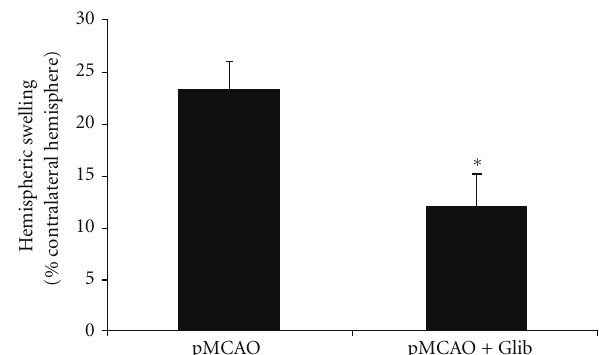
Figure 2: Glib attenuates hemispheric swelling in a rat model of pMCAO. The extent of swelling was calculated using the equation: Extent of edema = (volume of ipsilateral hemisphere − volume of contralateral hemisphere)/volume of contralateral hemisphere. Treatment with Glib significantly decreased hemispheric swelling compared to the vehicle-treated group at 48 h. P < 0.05; ∗ significant di ff erence compared to MCAO + Vehicle. Values are expressed as mean ± SE.